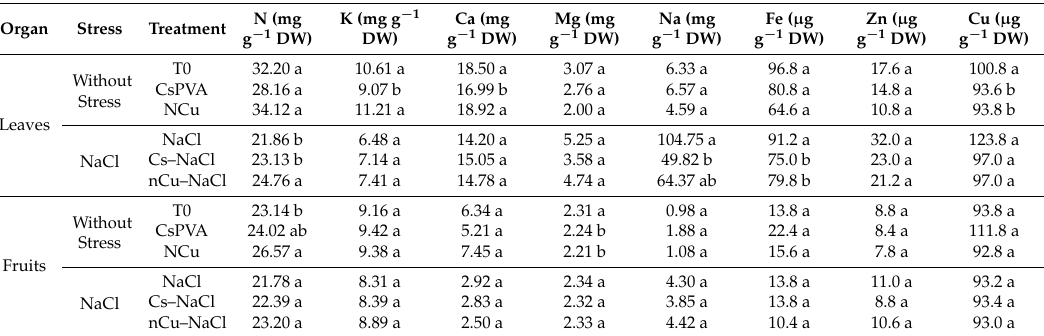
Table 6. Mineral content in tomato leaves and